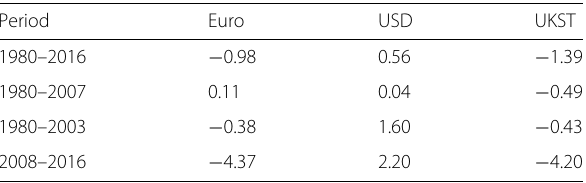
Table 5 Return differentials on equity portfolios after